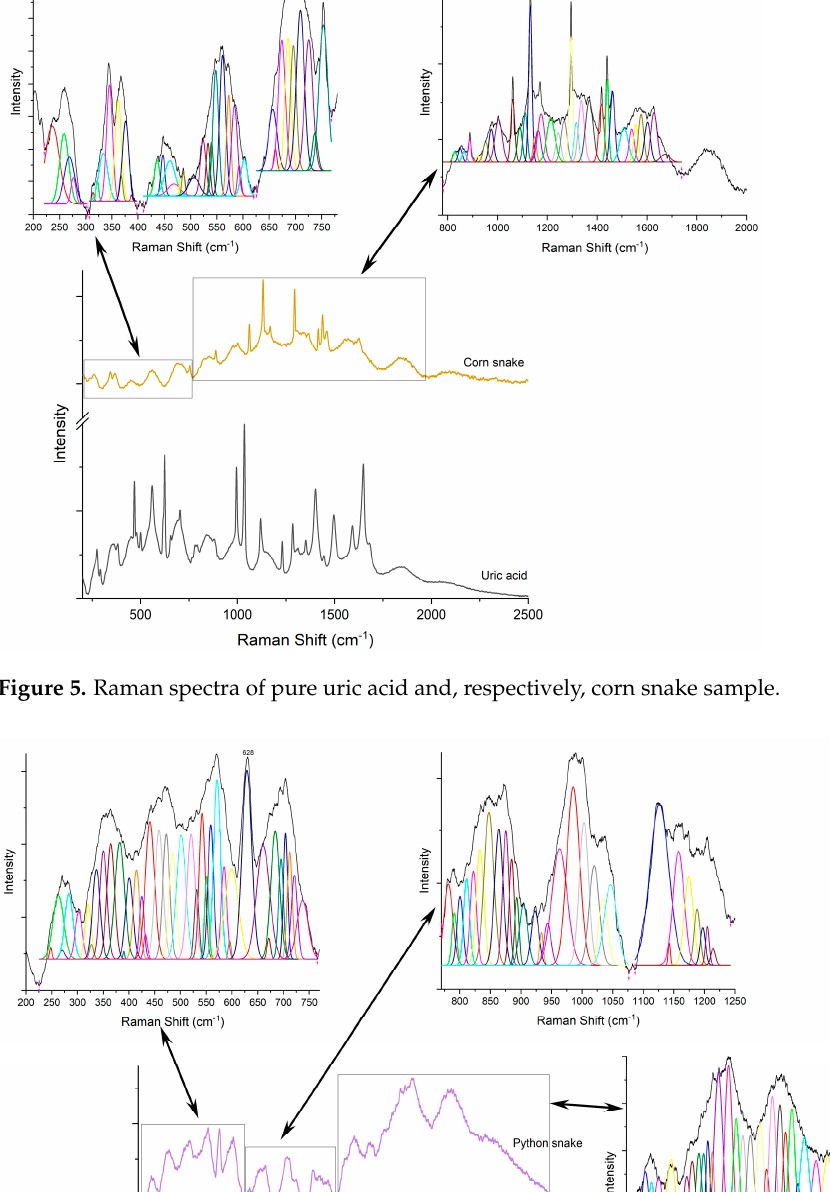
Figure 4. Raman spectra of pure uric acid and, respectively, chameleon sample.